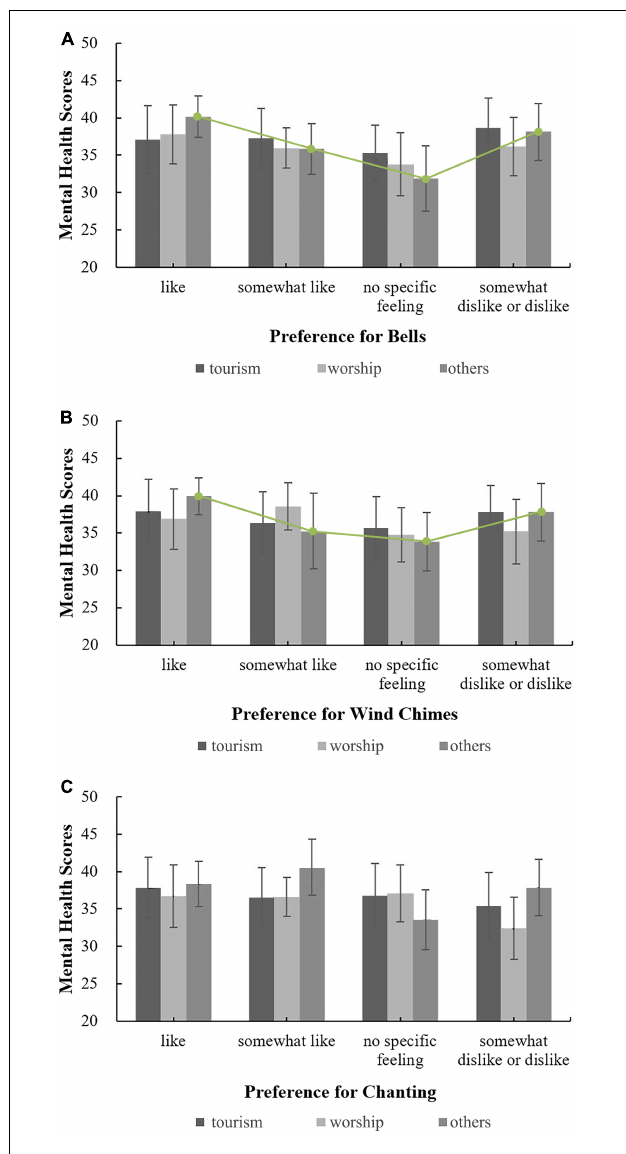
FIGURE 9 | The relationships between sound preferences and mental health by purpose for visiting. (A) Bells; (B) Wind chimes; (C)